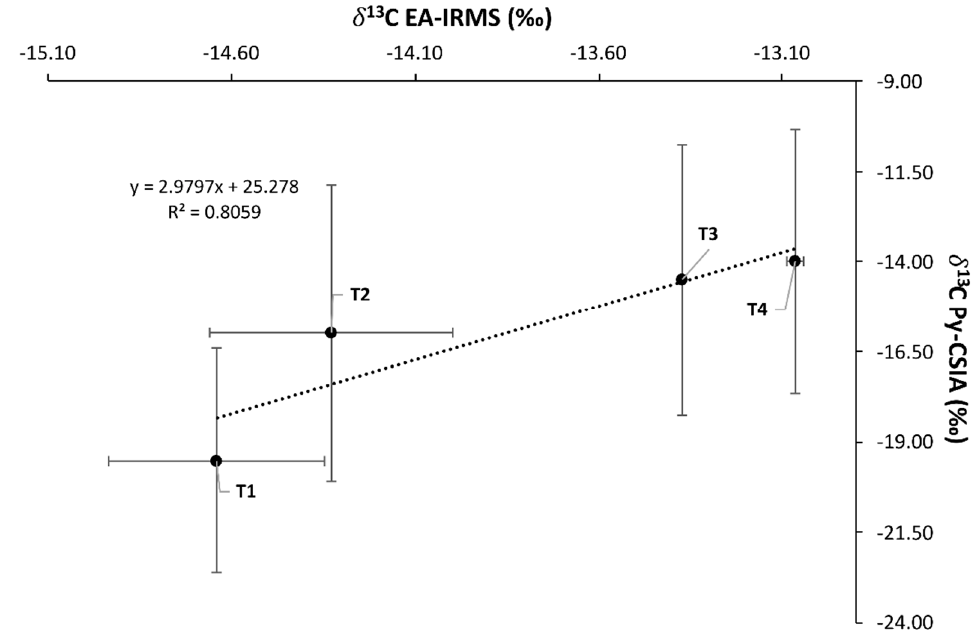
Figure 5. Correlation between δ 13 C mean values obtained from Py-CSIA ( n = 3) versus EA-IRMS values ( n = 2). Error bars represent mean standard deviation (horizontal: bulk measurements; vertical: Py-CSIA).